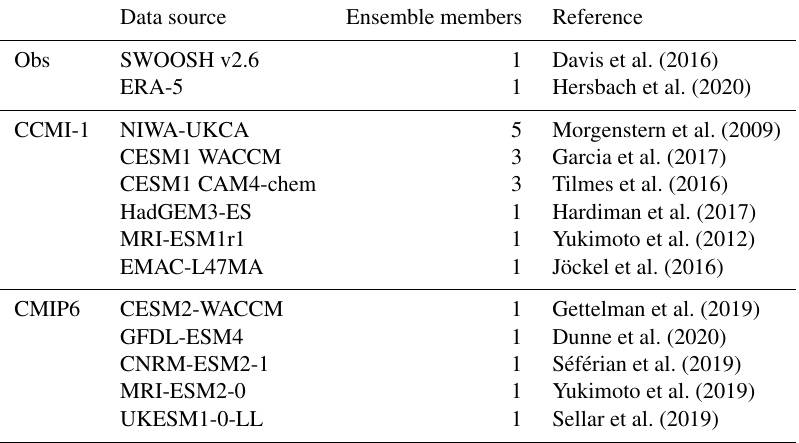
Table 2. The data sources used in this study. For CMIP6 models we focus on the historical integrations of the period 1850 to 2014 and for CCMI phase 1 the Ref-C2 simulations spanning the years 1960 to 2100. The CCMI-1 models CESM1 WACCM, CESM1 CAM4-chem and EMAC-L47MA nudge the QBO; the rest spontaneously generate the